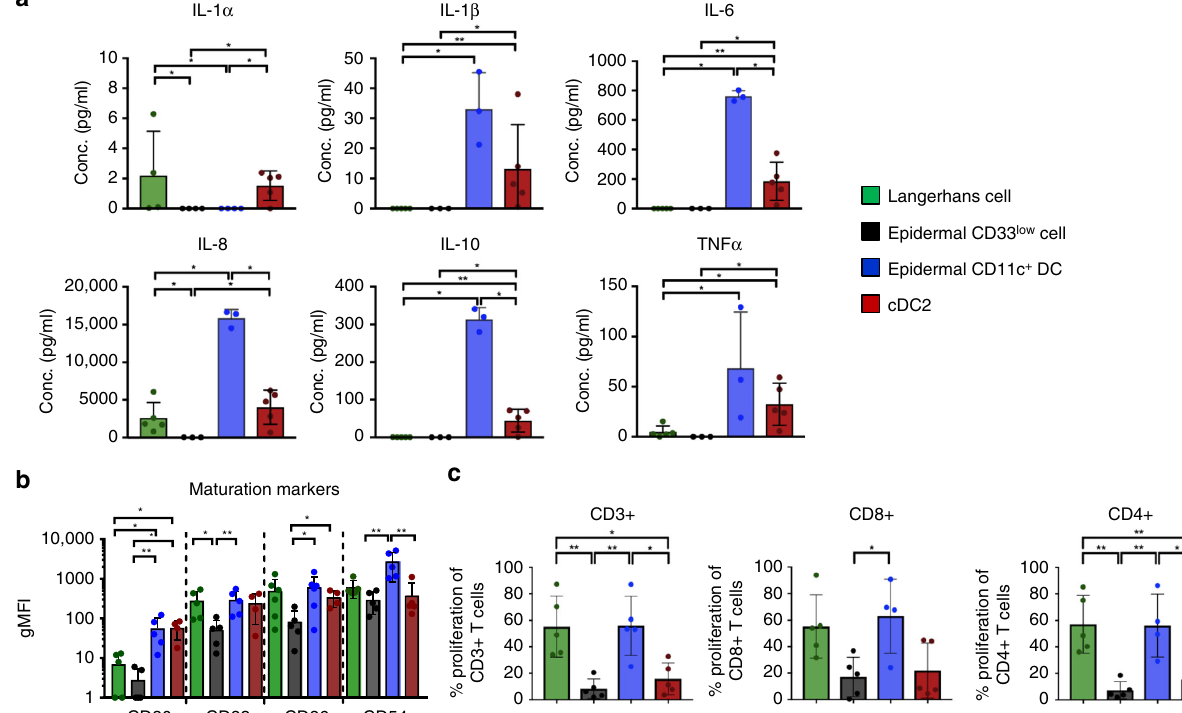
Fig. 4 Functional phenotyping of human epidermal mononuclear phagocytes. Mononuclear phagocytes were liberated from human epidermis using Type IV collagenase. cDC2 were also isolated from dermis. a Each subset was FACS sorted and then cultured overnight in a cocktail of TLR agonists. The supernatants were collected and a cytometric bead array was carried out to determine the amounts of IL-1 α , IL-1 β , IL-6, IL-8, IL-10 and TNF α . Results expressed as mean ± standard deviation with each dot representing an individual donor. Statistical analysis was generated using the Mann – Whitney